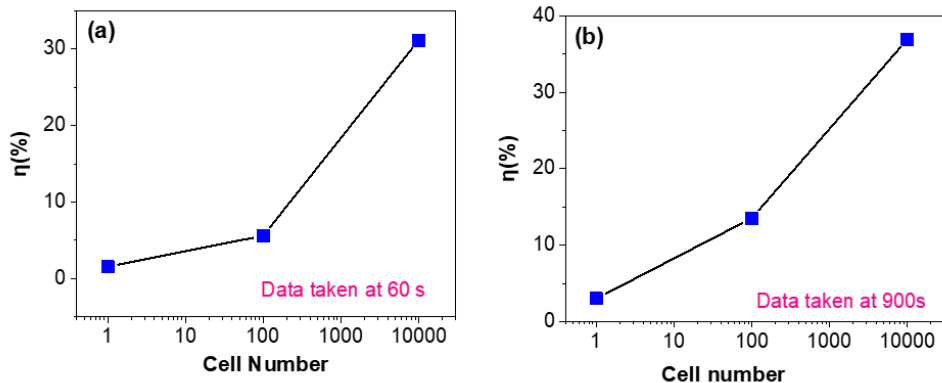
Figure 5. Cell number dependence of sensitivity after a fixed detection time of 60 s ( a ) or 900 s ( b ). The time dependence of the response for four different biosensors at a fixed cancer